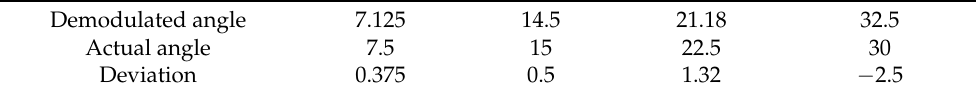
Table 1. The demodulated and actual deflection angles of the airflow ( ◦